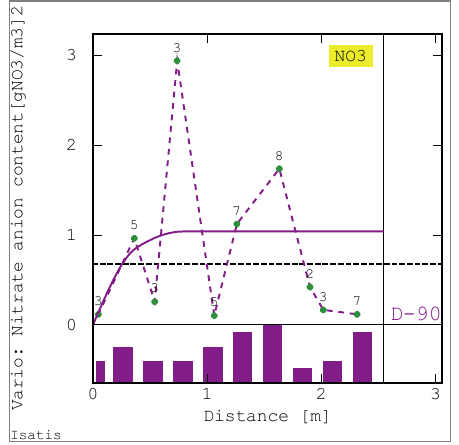
Fig. 19a. Directional semivariogram (D-90) of oxidation-reduction potential pH in underground water in Kłodzko intake area; 14 wells